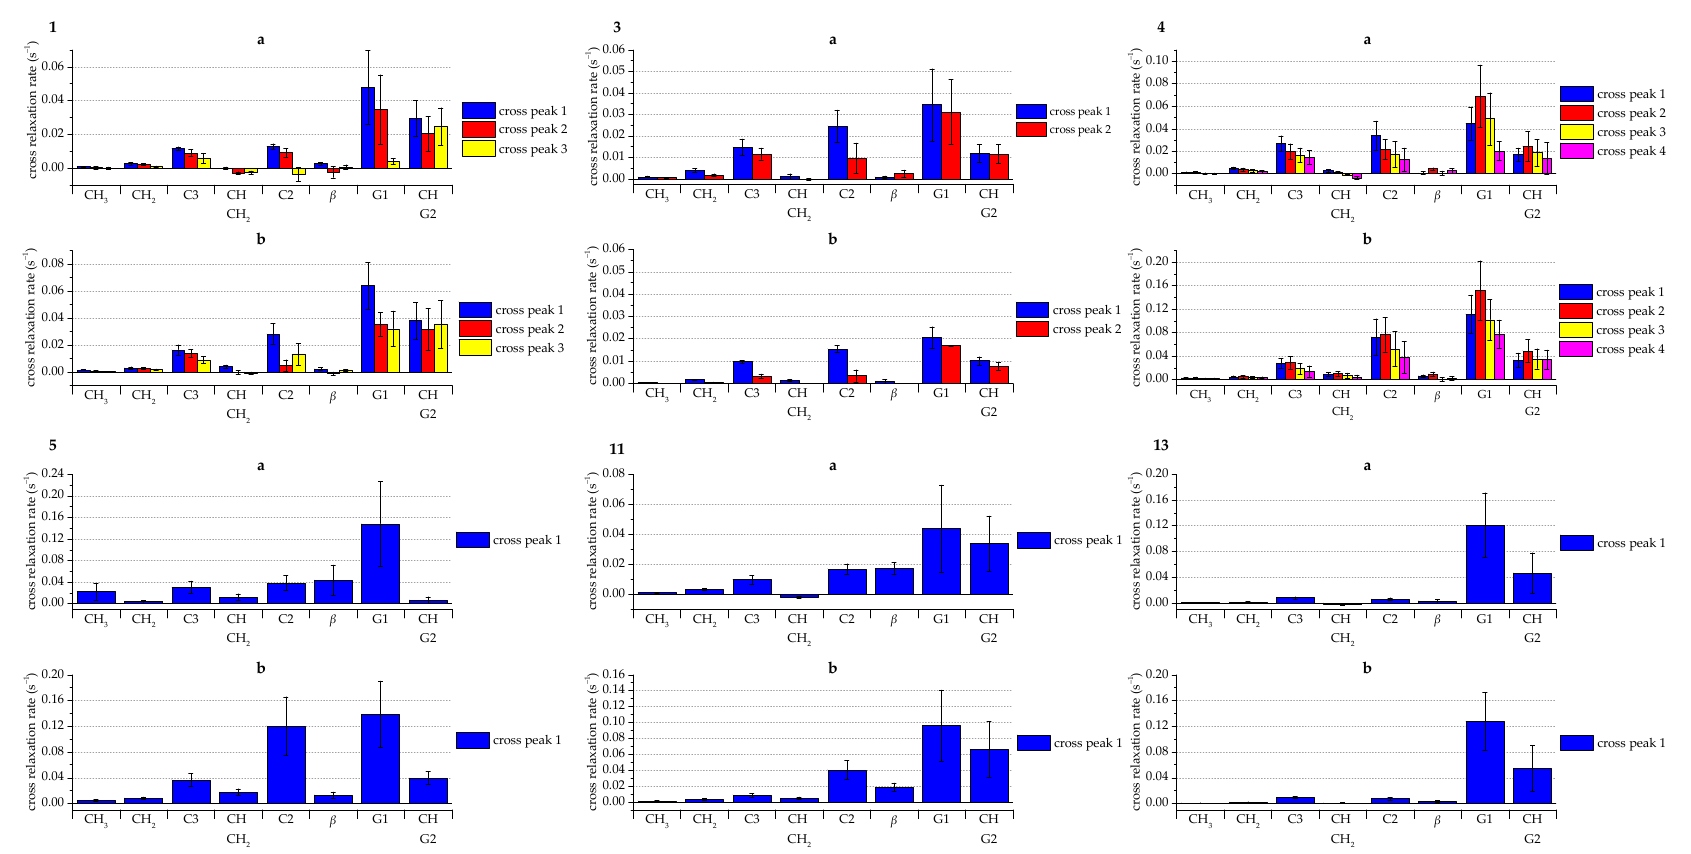
Figure 4. Cross relaxation rates of the aromatic protons (cross peaks 1–4 refer to Section 3.3 for definitions) of tellimagrandin I 1 , casuarictin 3 , tellimagrandin II 4 , pentagalloylglucose 5 , sanguiin H-6 11 , and lambertianin C 13 against different lipid protons with mixing times of ( a ) 0.1 s and ( b ) 0.3 s. The tannin numbering refers to Figure 1 and lipid proton assignations refer to Figure 5. Cross peak labels are defined in Section 3.3. Values are presented as s − 1 (average values and standard error, n = 4).